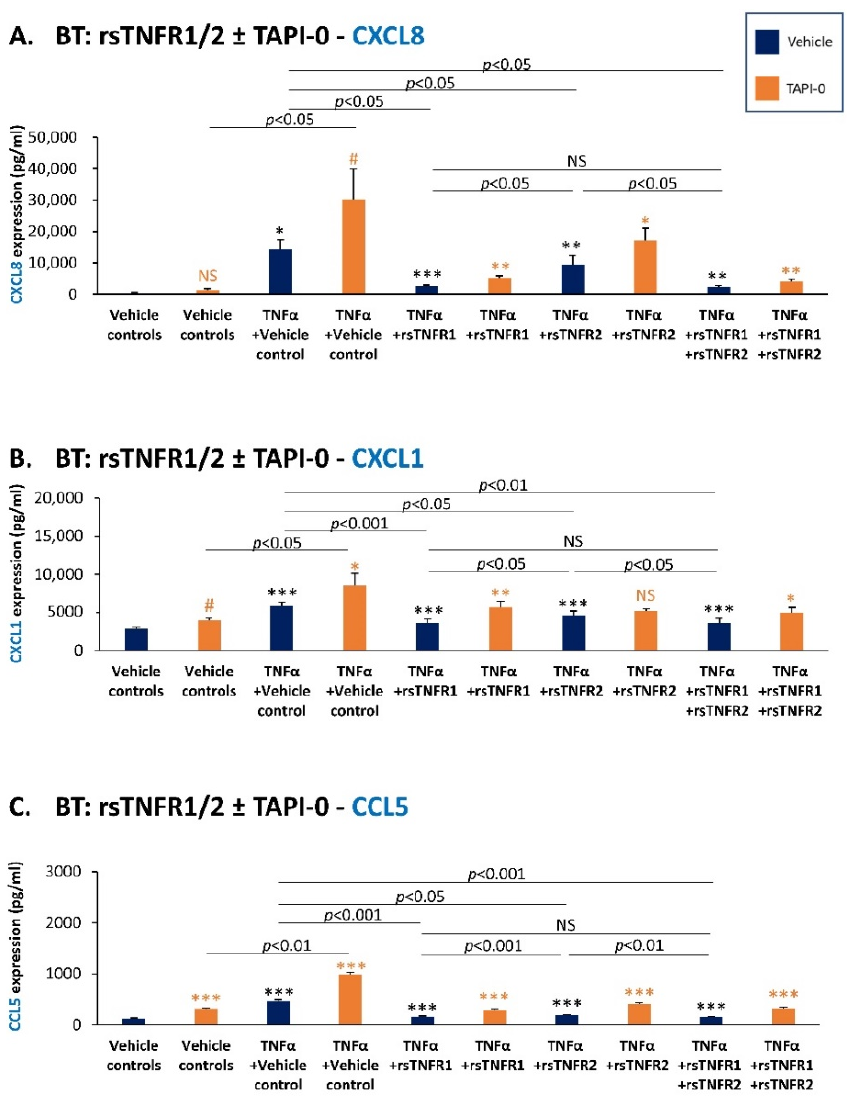
Figure 10. Recombinant and cell-derived sTNFR1 and sTNFR2 have a protective effect against TNF α - induced expression of pro-metastatic chemokines in BT-549 cells. BT-549 cells (BT) were stimulated by TNF α (0.25–0.5 ng/mL) that was pre-incubated with rsTNFR1 (150 ng/mL), rsTNFR2 (500 ng/mL), rsTNFR1 + rsTNFR2 (concentrations as before) or their vehicle. When indicated, the cells were cultured prior to TNF α stimulation with TAPI-0 (5 µ g/mL) or its vehicle for 3 h, as well as during cytokine stimulation (TAPI-0 did not affect tumor cell growth). The concentrations of rsTNFR1 and rsTNFR2 were selected as described in Section 2. CM were collected following 24 h stimulation, and CXCL8 ( A ), CXCL1 ( B ) and CCL5 ( C ) levels were determined by ELISA. A representative experiment of n = 3 is presented. *** p < 0.001, ** p < 0.01, * p < 0.05, # p < 0.1. NS, not significant. Black asterisks denote the differences in chemokine levels between TNF α -stimulated cells and vehicle-treated cells. Orange asterisks denote the differences in chemokine levels between TAPI-0-treated cells and cells treated by its vehicle. Statistical analyses were performed as described in Section 2. Overall, our findings indicate that sTNFR1 and sTNFR2 inhibit the ability of TNF α - gression. Thus, sTNFR1 and sTNFR2 may be considered as protective and anti-malignancy factors in